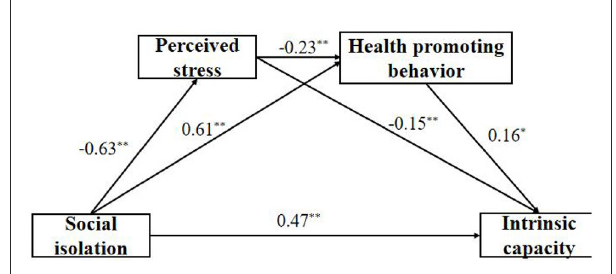
FIGURE1 The chain mediating effect of perceived stress and health promoting behavior between health promoting behavior and intrinsic capacity. * P < 0.05, ** P <